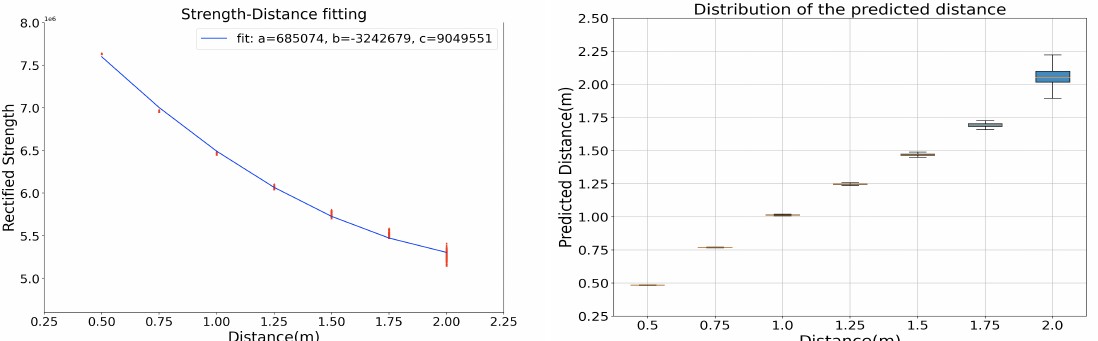
Figure 11. Fitted strength-distance relation and the distribution of the predicted distance with the fitting equation with a